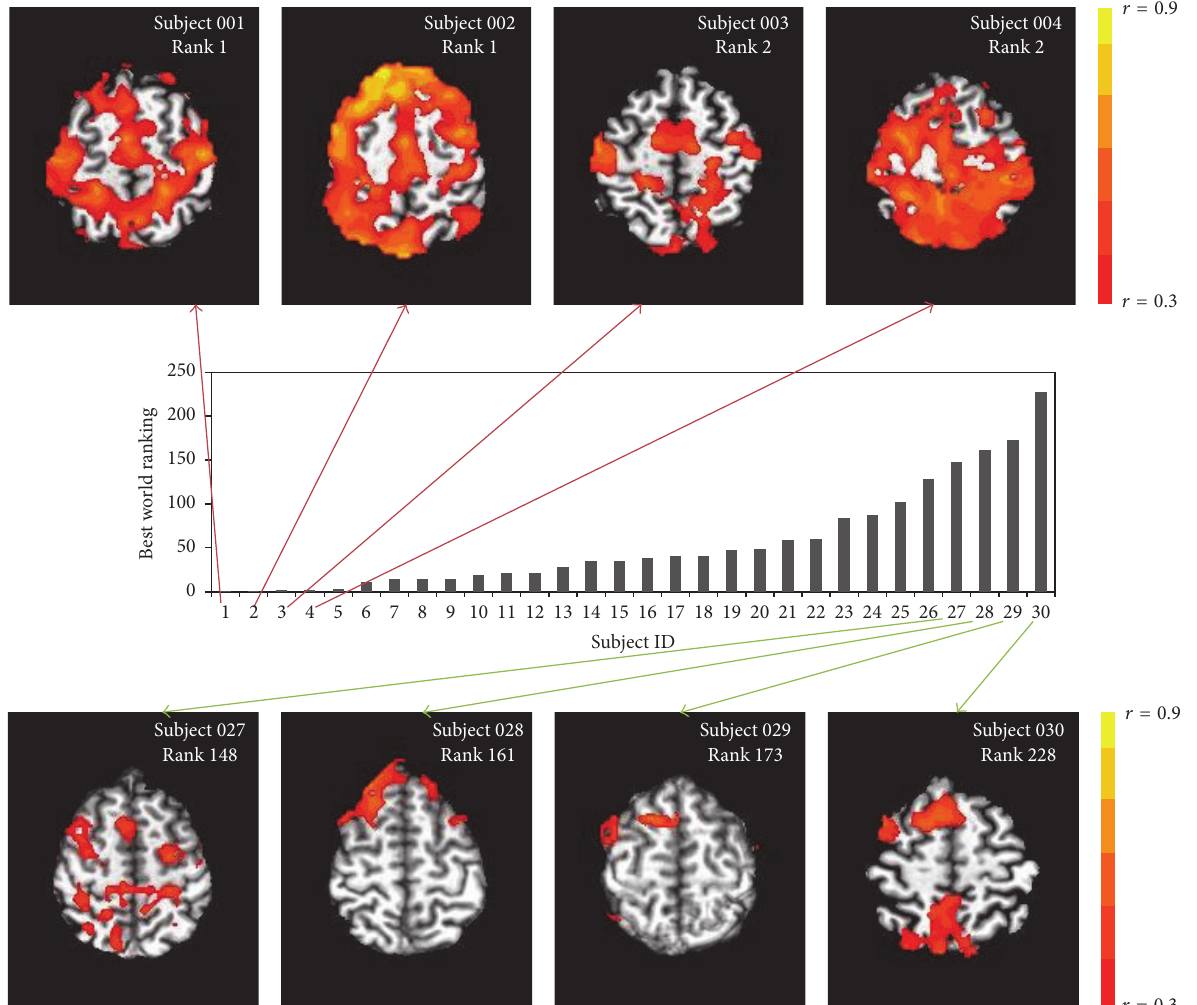
Figure 4: Thalamus-seed functional connectivity maps for eight representative individuals thresholding at voxel-wise correlation coefficient (𝑟) > 0.3 .